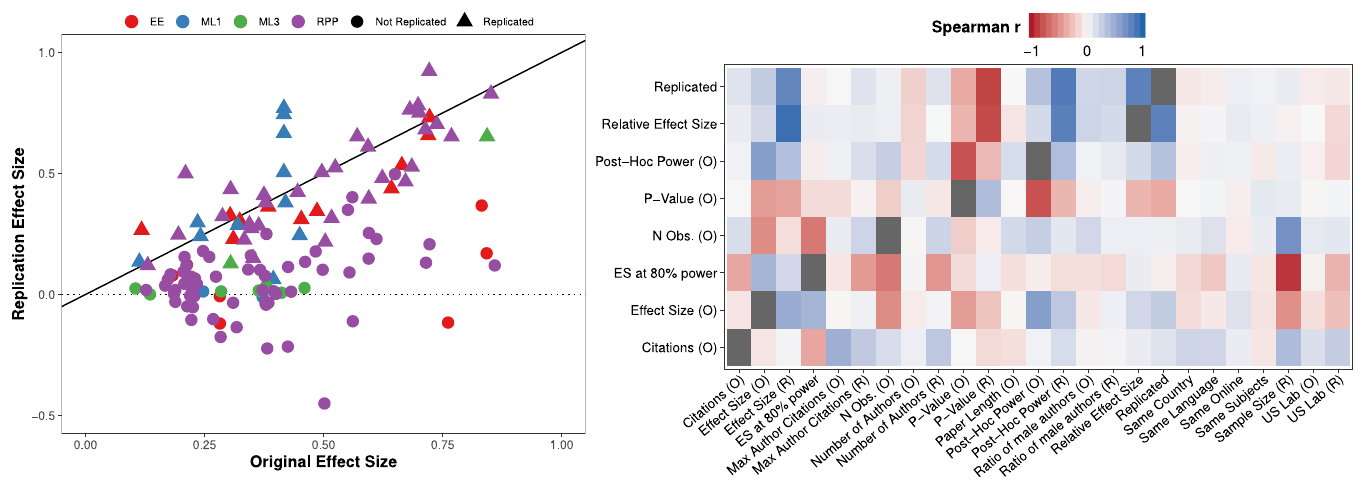
Fig 1. Effect sizes and correlations. (A) A plot of effect sizes ( r ) in each study pair. Data source is coded by color. Symbol shape denotes whether a study replicated (binary measure). Most points are below the 45-degree line, indicating that effect sizes are smaller in replications. Replications with a negative effect size have effects in the opposite direction compared to the original study. (B) A heatmap showing Spearman rank-order correlations between variables. Y-axis shows most important features with the two dependent variables on the top. O and R in the variable label correspond to original and replication studies, respectively. Plus and minus indicate positive and negative correlations respectively. Most correlations are weak. See S1 Table for variable definitions and S1 Fig for a full correlation plot.